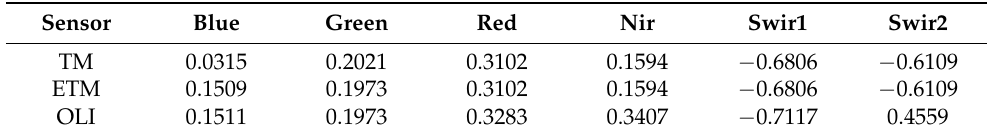
Table 1. Corresponding wetness index coefficients for different sensors.